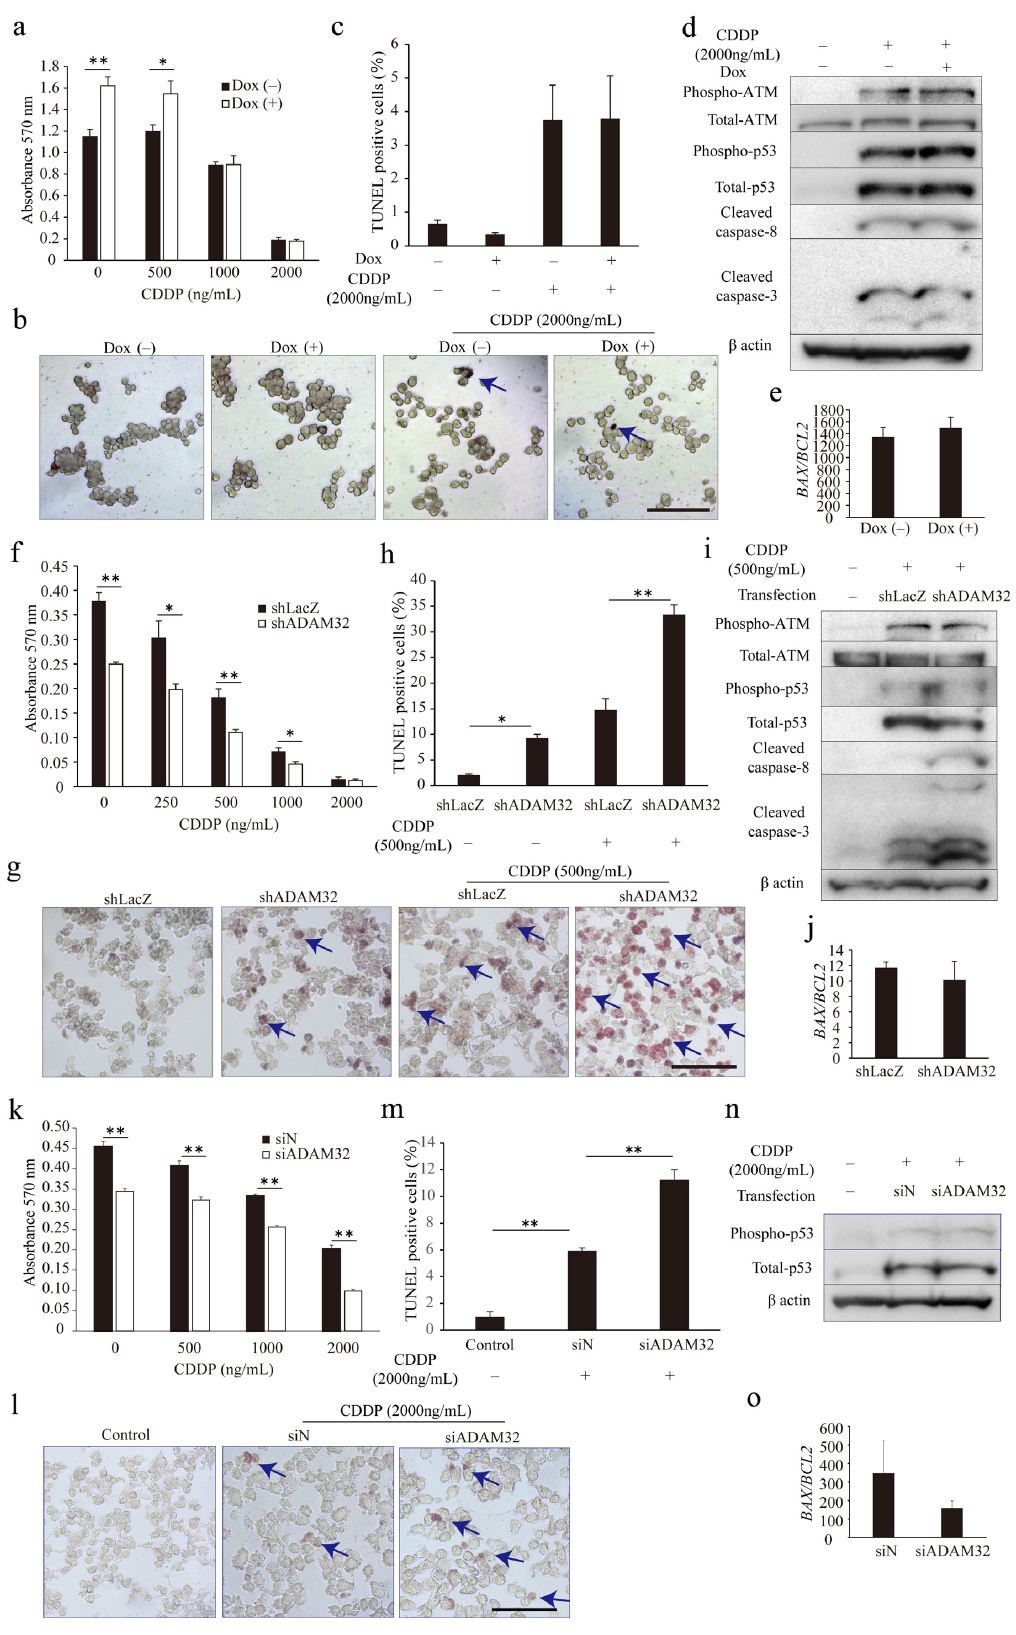
Figure 5. ADAM32 shows antiapoptotic function in CDDP-treated cancer cells. ( a ) HepG2 Tet cells were incubated with or without Dox for 96 h and then treated with CDDP at different